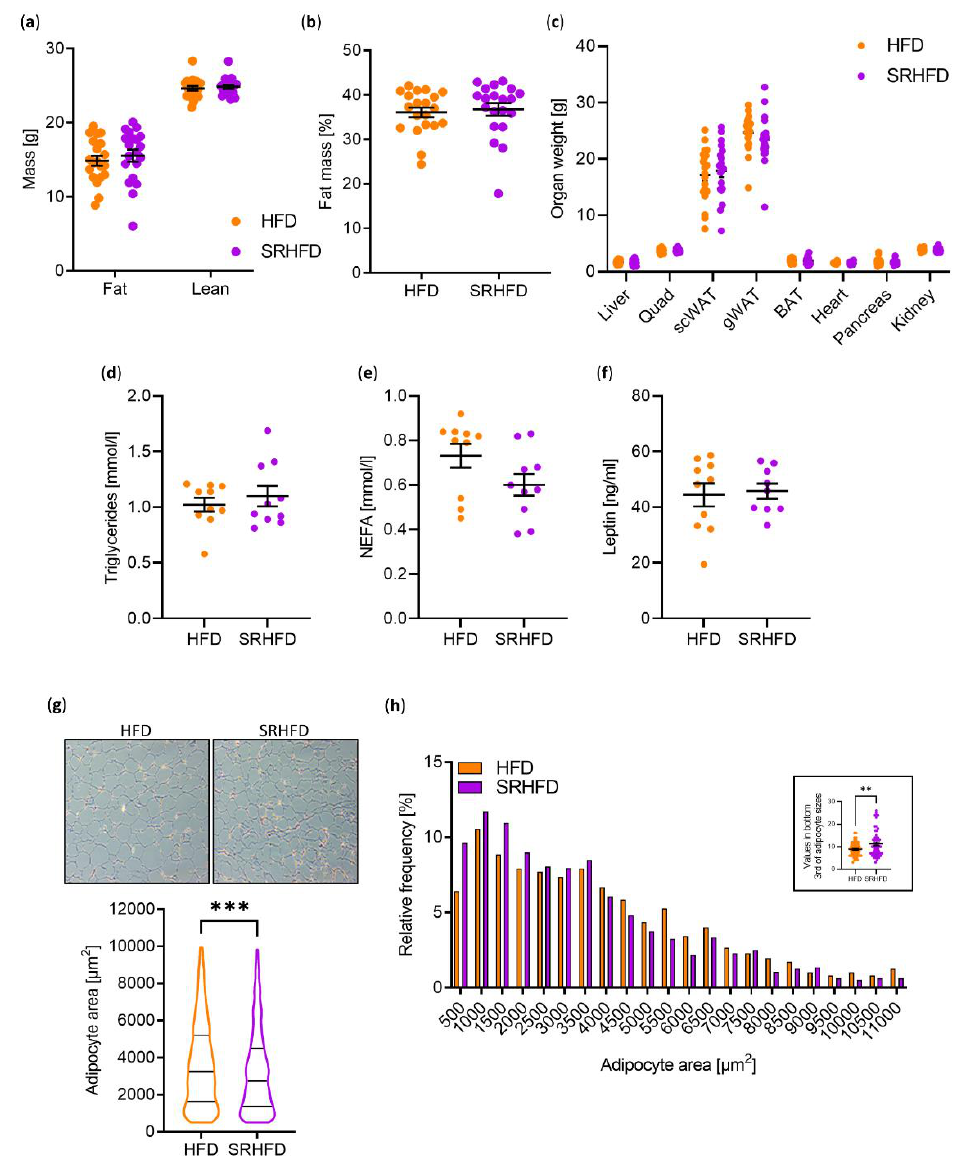
Figure 4. Selenite treatment in established obesity improves adipocyte morphology. ( a ) Body composition measured via NMR of male C57BL/6N mice fed either HFD or SRHFD for 9 weeks after established obesity. ( b ) Body fat percentage calculated from ( a ). ( c ) Final tissue weights of male C57BL/6N mice fed either HFD or SRHFD for 10 weeks after established obesity. ( d – f ) Final triglyceride ( d ), non-esterified fatty acids (NEFA, e ), and leptin ( f ) levels in plasma of male C57BL/6N mice fed either HFD or SRHFD for 10 weeks after established obesity. ( g , h ) Morphology, area ( g ), and size distribution ( h ) of gonadal white adipocytes of C57BL/6N mice fed either HFD or SRHFD for 10 weeks after established obesity. **: p < 0.01, ***: p < 0.001 after two-tailed Student’s t -test. All data are presented as mean ±